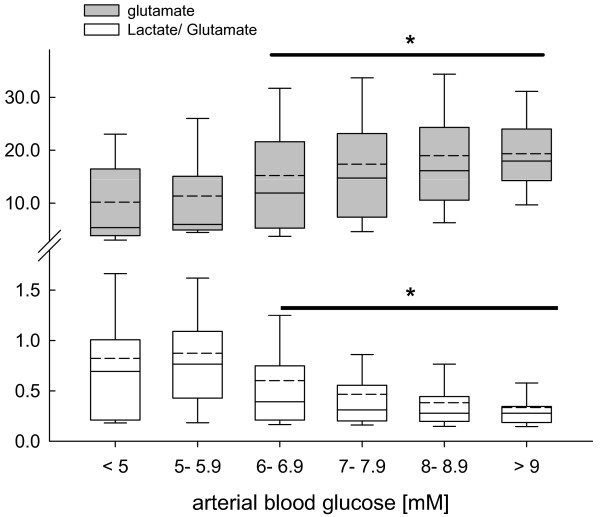
Changes in brain glutamate (grey box plots) and calculated lactate-to-glutamate (white box plots) ratio determined by microdialysis reflecting influence of blood glucose on downstream cerebral metabolism in pre-defined arterial blood glucose clusters, ranging from less than 5 mM to more than 9 mM in 1 mM buckets. At arterial blood glucose levels exceeding 6 mM brain glutamate was significantly increased. In parallel, calculated lactate-to-glutamate was significantly decreased. Alterations across the pre-defined blood glucose clusters compared with low arterial blood glucose levels were significant (*P < 0.001; analysis of variance on ranks, post hoc Dunn's test).